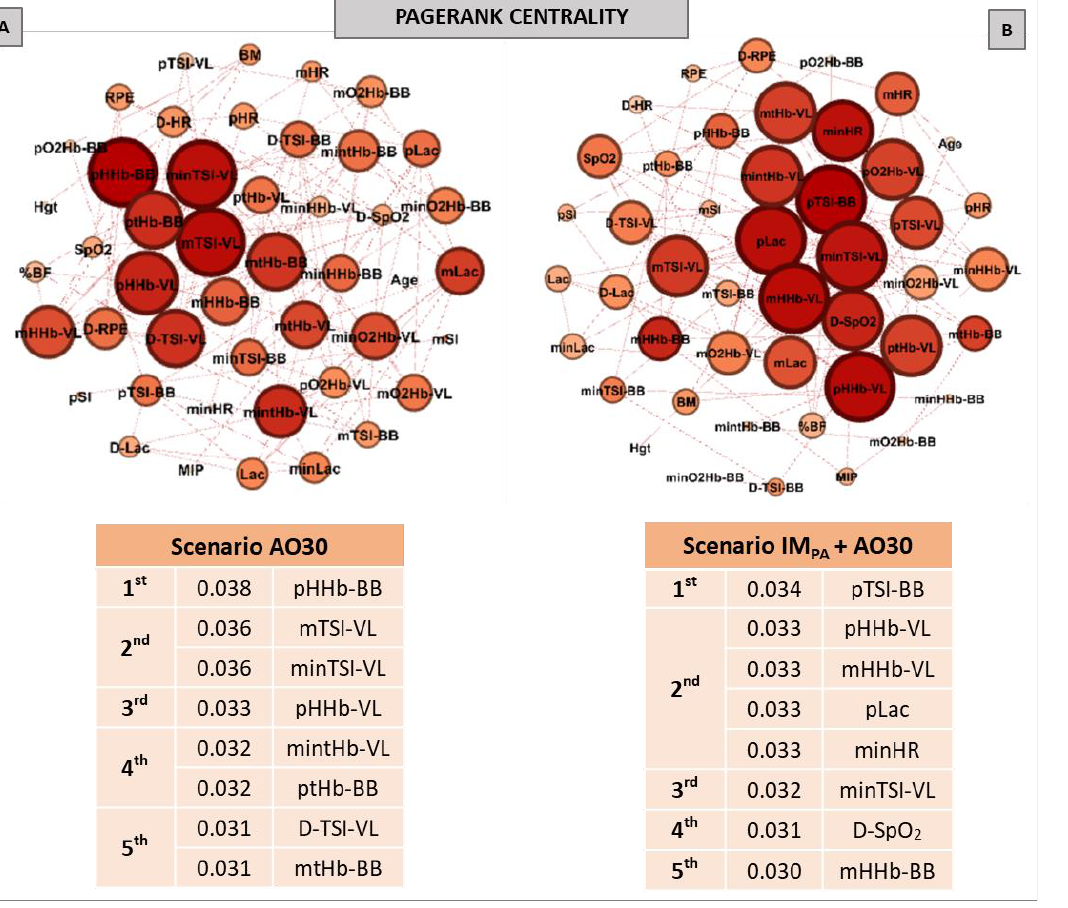
Figure 4. Graphs and top five node results obtained by complex network analysis using the Pagerank metric in exercise scenarios without inspiratory muscle pre-activation (Scenario AO30, at Panel A ) and with inspiratory muscle pre-activation (Scenario IM PA + AO30, at Panel B ). Graph visualizations were done using Gephi software (version 0.9.2, Paris, France). Legend: AO30 = all-out 30 s, IM PA = inspiratory muscle pre-activation, Hgt = height, BM = body mass, %BF = percentual of body fat, MIP = maximal inspiratory pressure, SI = global strength index of inspiratory muscles, Lac = blood lactate, HR = heart rate, SpO 2 = arterial oxygen saturation, RPE = perceived exertion, O 2 Hb = oxyhemoglobin relative concentration, HHb = deoxyhemoglobin relative concentration, tHb = total hemoglobin, TSI = tissue saturation index. Abbreviations accompanied by p , m, min and D represent peak, mean, minimum and delta (between the final and initial results), respectively. Ab- breviations accompanied by BB and VL represent the results in the biceps brachii and vastus lat- eralis, respectively.